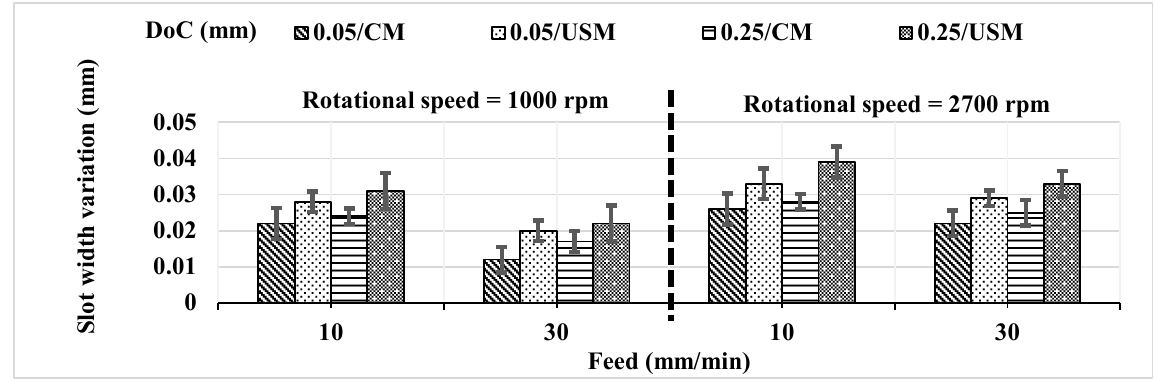
Figure 20. Slot width variations at different cutting parameters.